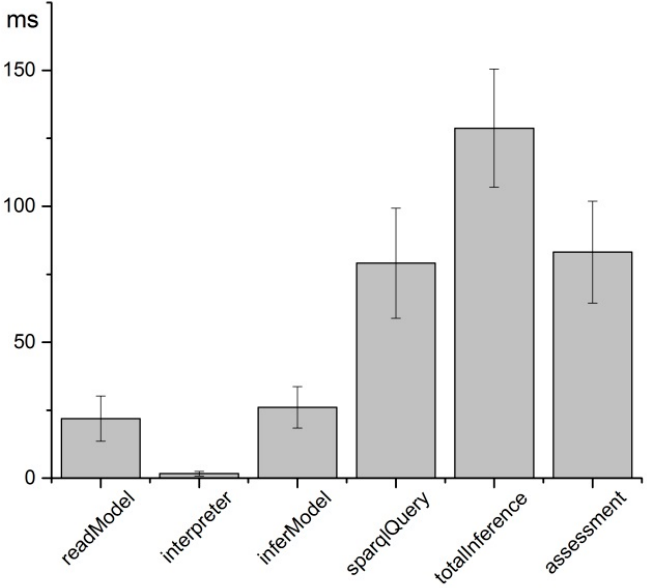
Figure 8. Time consumption from the sensory data to assessment status.